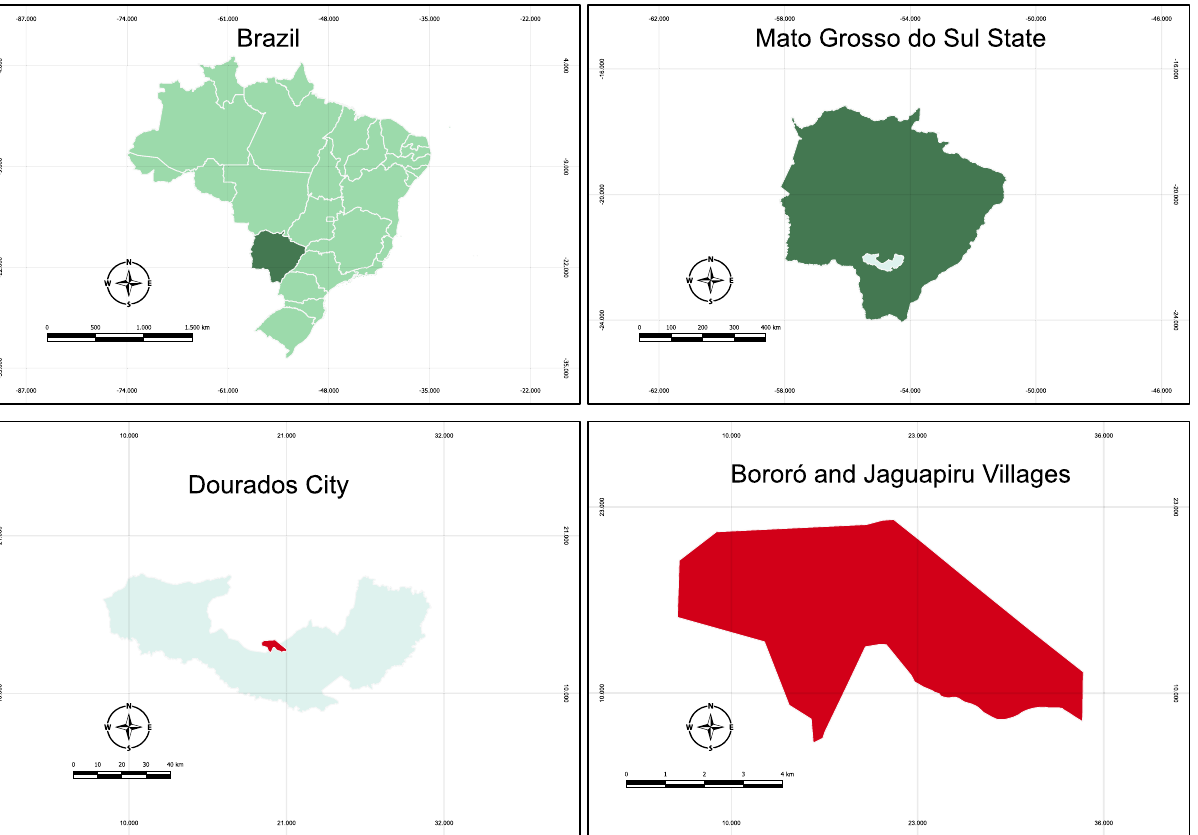
Figure 1. Map of the Central Brazil region showing the geographic location of the Bororó and Jaguapiru villages in the Dourados city, Mato Grosso do Sul state (MS). The map was constructed using the software